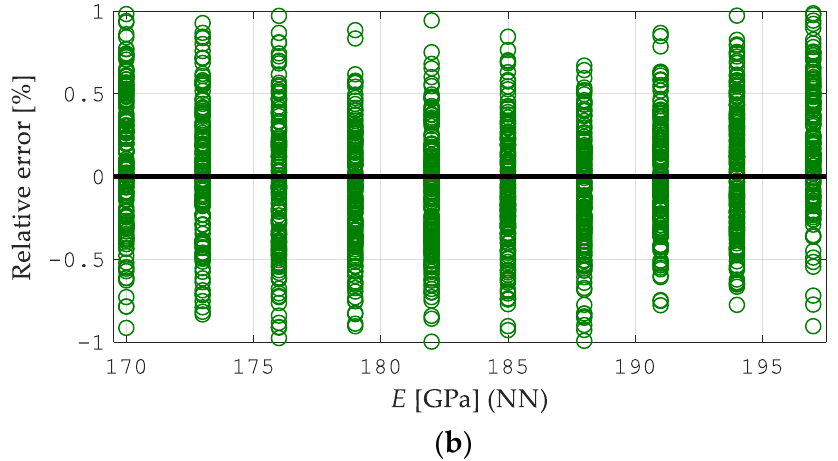
Figure 10. Errors of the P-A and P-C procedures in the estimates of Young’s modulus E : ( a ) histogram of the error distribution, ( b ) the error distribution of the parameter values.